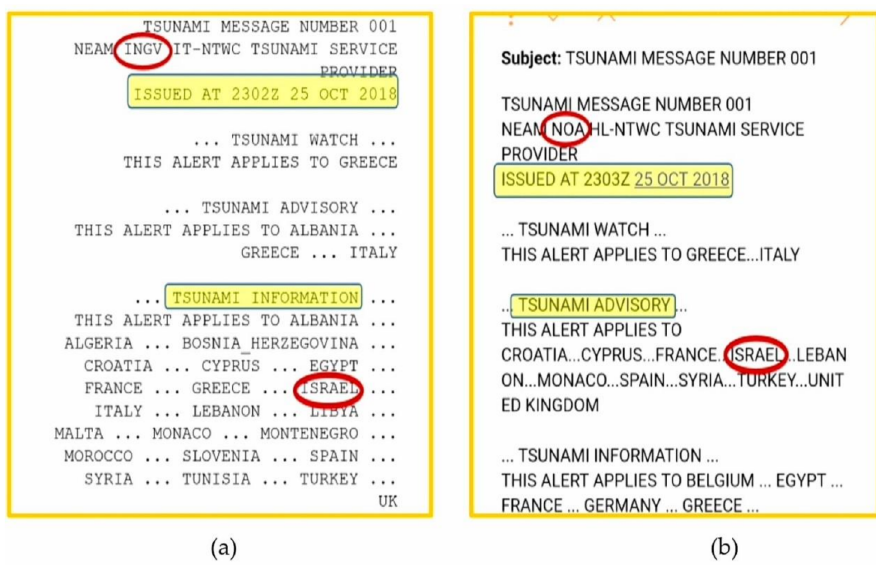
Figure 6. Tsunami alert messages received in Israel regarding the 25 October 2018 earthquake southwest of Greece: ( a ) INGV message issued on 23:02 “Tsunami Information” to Israel; ( b ) NOA message issued on 23:03 “Tsunami Advisory” to